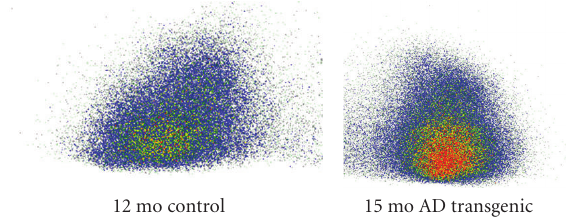
Figure 5: 125 ICQ BCA NPs (1 hour postinjection).